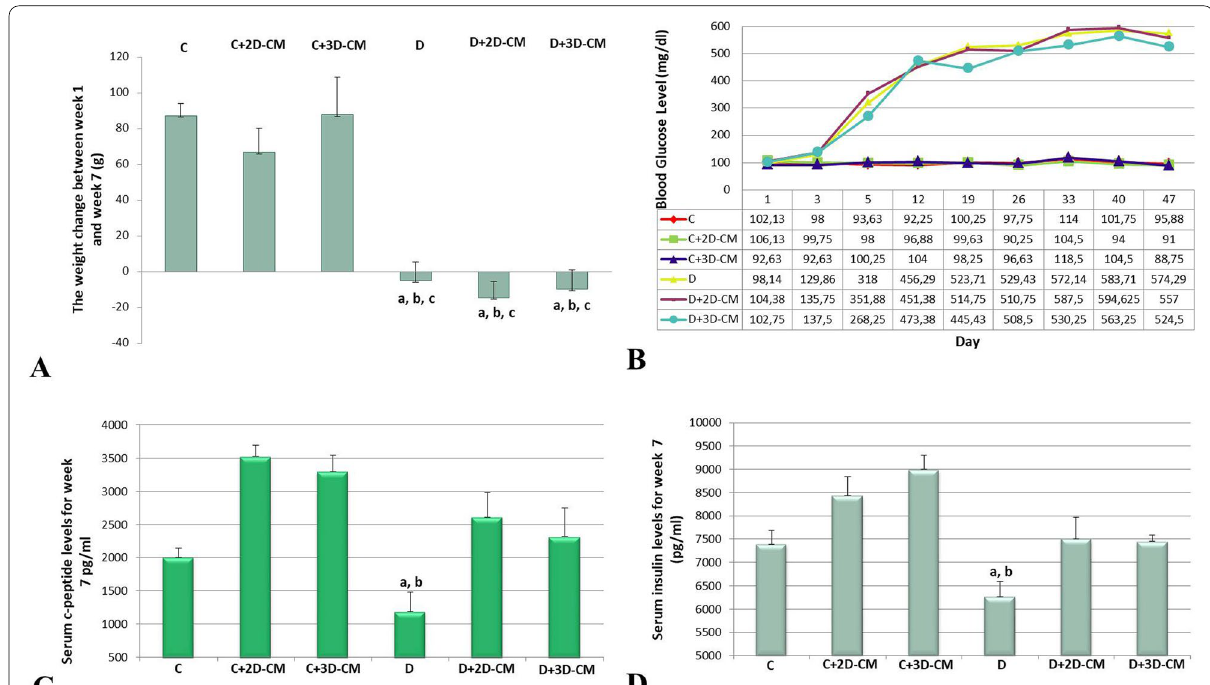
Fig. 3 Body weight, blood glucose, serum C‑peptide, and serum insulin analysis. A Weight change of the animals between 1st week and 7th week (g). a p < 0.001 versus the C group, b p < 0.01 versus the C ( n 8). B Mean blood glucose levels of the animals during the experiment period ( n = the C 2D‑CM group, b p < 0.05 versus the C + versus the C 3D‑CM group. Data are presented as mean +